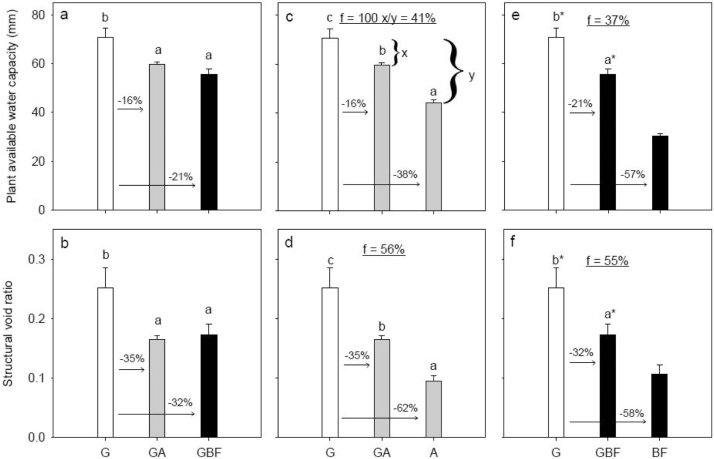
Degradation scenarios: Land use change effects on plant available water capacity calculated based on a soil mass equivalent to 20 cm in the G soil, and structural void ratio. White, gray and black bar fills represent grass, arable and bare fallow treatments, respectively, at time of sampling. Letters denote statistical significance at P < 0.05. An asterisk (*) indicates if BF is significantly different from GBF and G based on a pairwise t-test. The numbers above the arrows denote relative differences. The underlined number in the middle part of the figures denotes the rate of change, and was estimated by Eq. 9. An example of the calculation is shown in Fig. c. For treatment abbreviations, see Table 1.